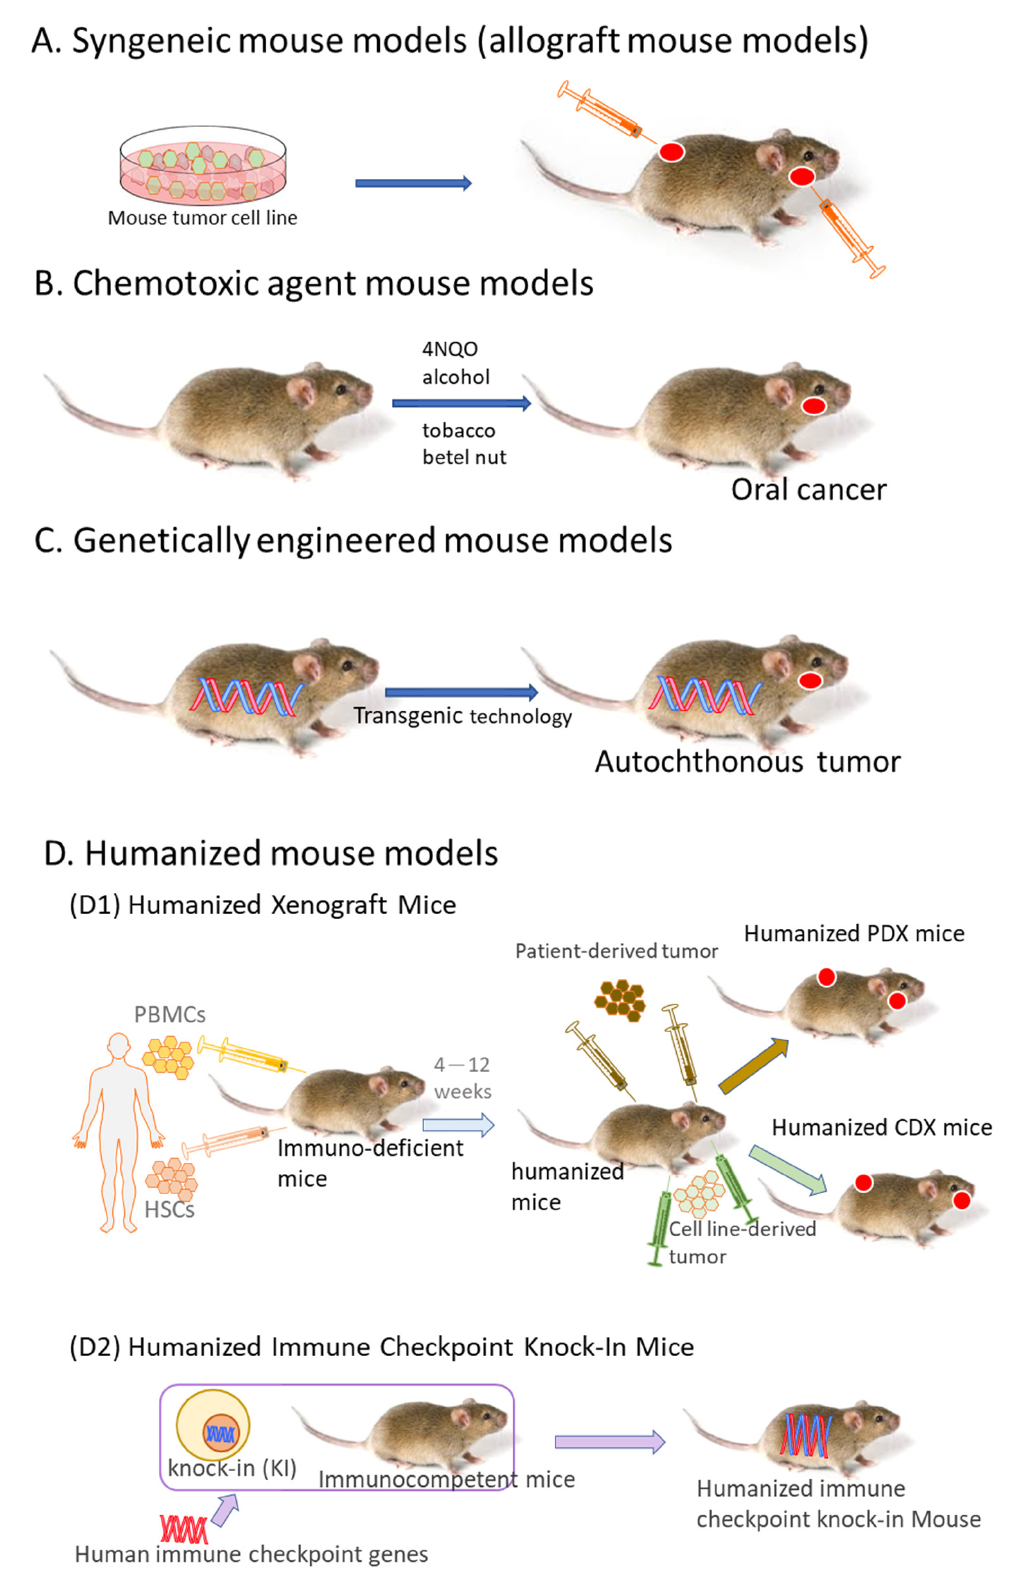
Figure 1. Murine models for oral tumor immunotherapy research. ( A ) Syngeneic tumor models use murine tumor cell lines grown and expanded in vitro that are then injected (subcutaneously or or- thotopically) into immunocompetent hosts. ( B ) Chemotoxic agent mouse models: Chemicals (car- cinogens) are administered to induce OSCC growth. In mice treated with carcinogens, the tumor also forms spontaneously de novo. ( C ) genetically engineered mouse models use autochthonous